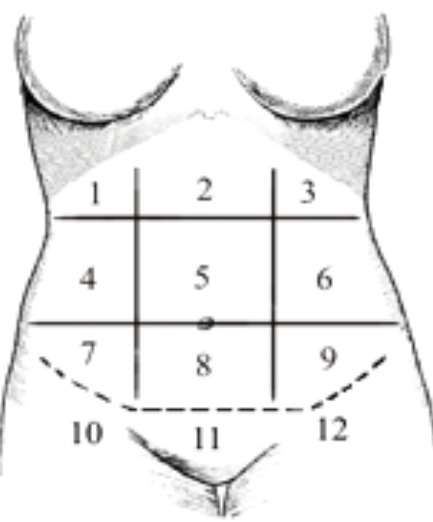
FIGURE 1 : Diagram showing the demarcation of the 12 areas of the